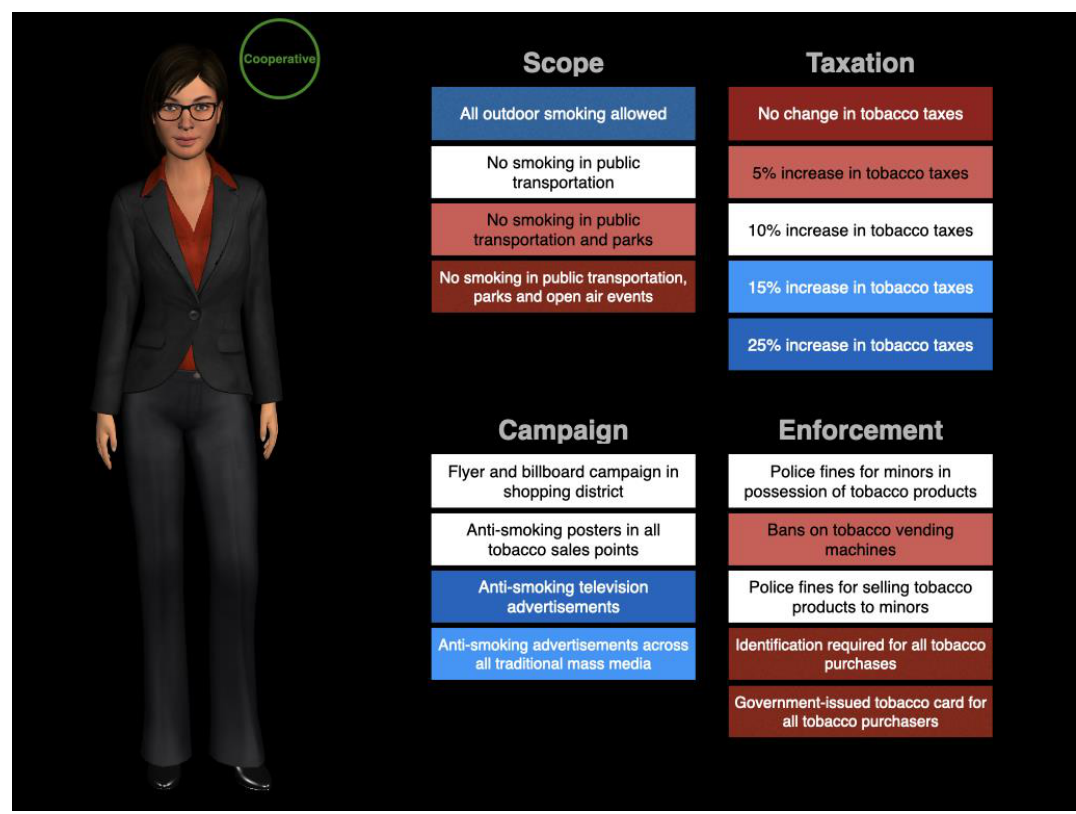
Figure 1. The multimodal embodied conversational agents (ECA; negotiator) and the multi-issue negotiation environment [26].